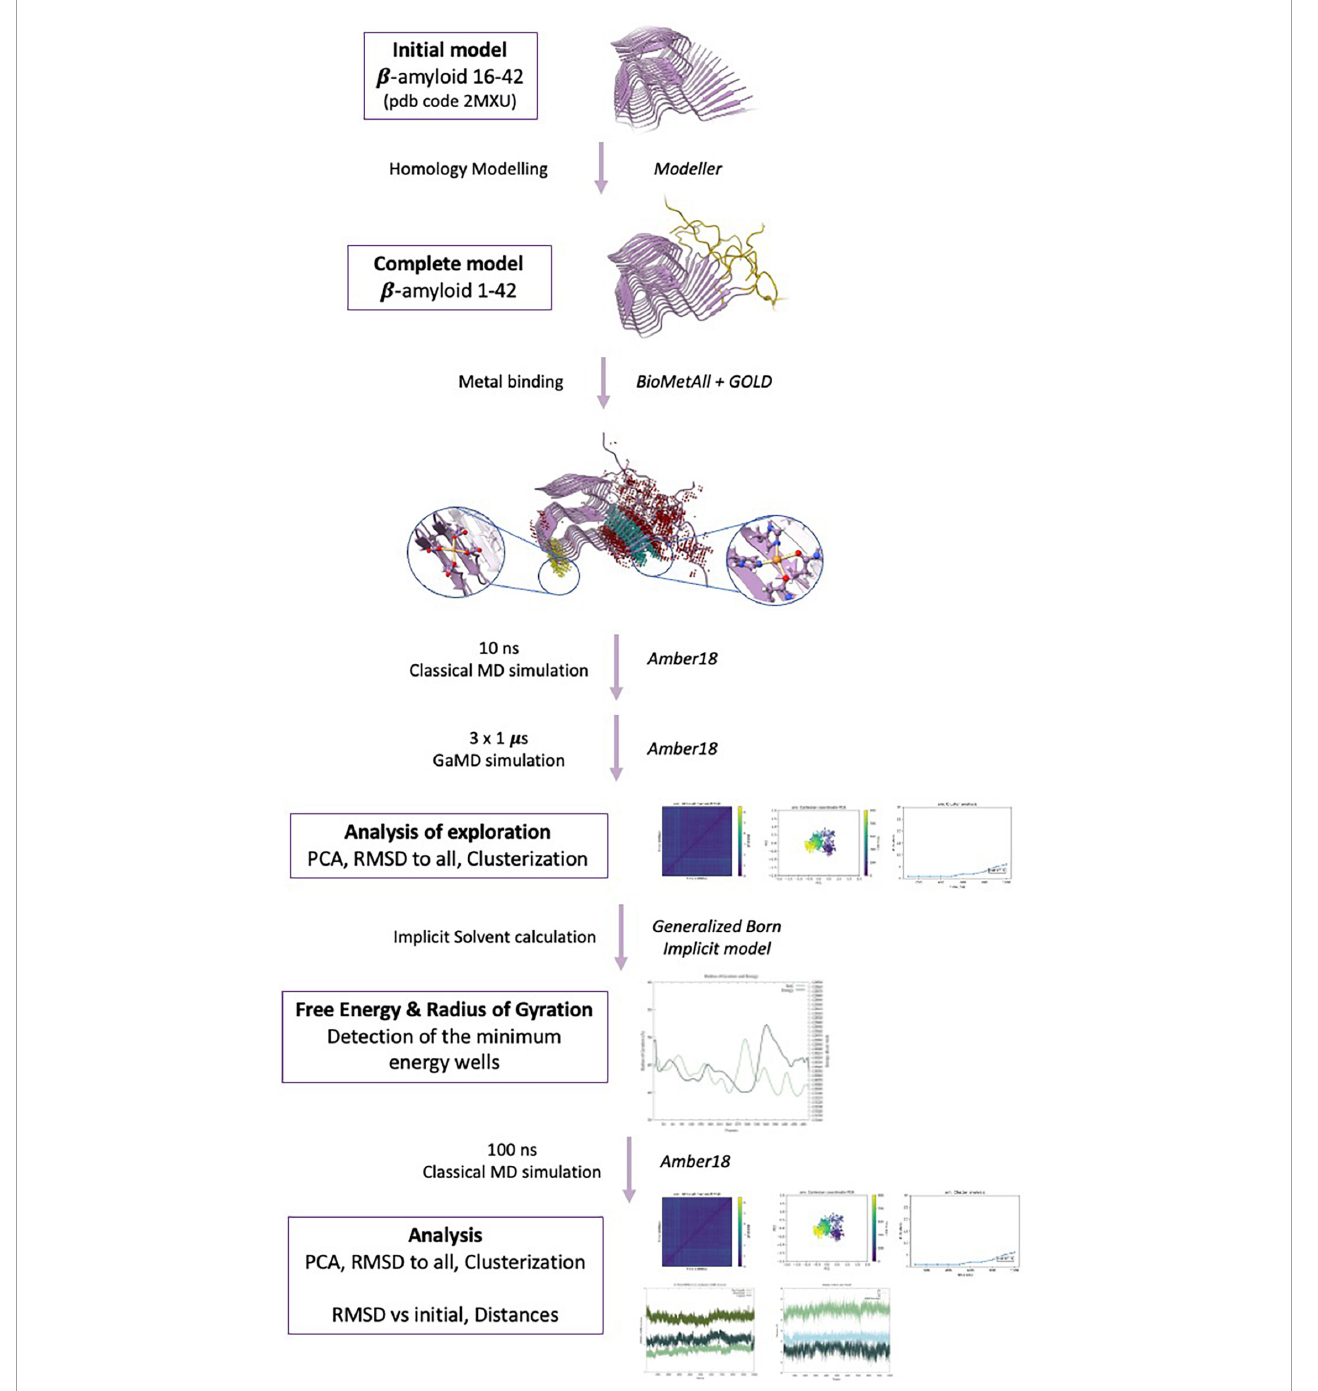
FIGURE1 Methodological protocol used in the present